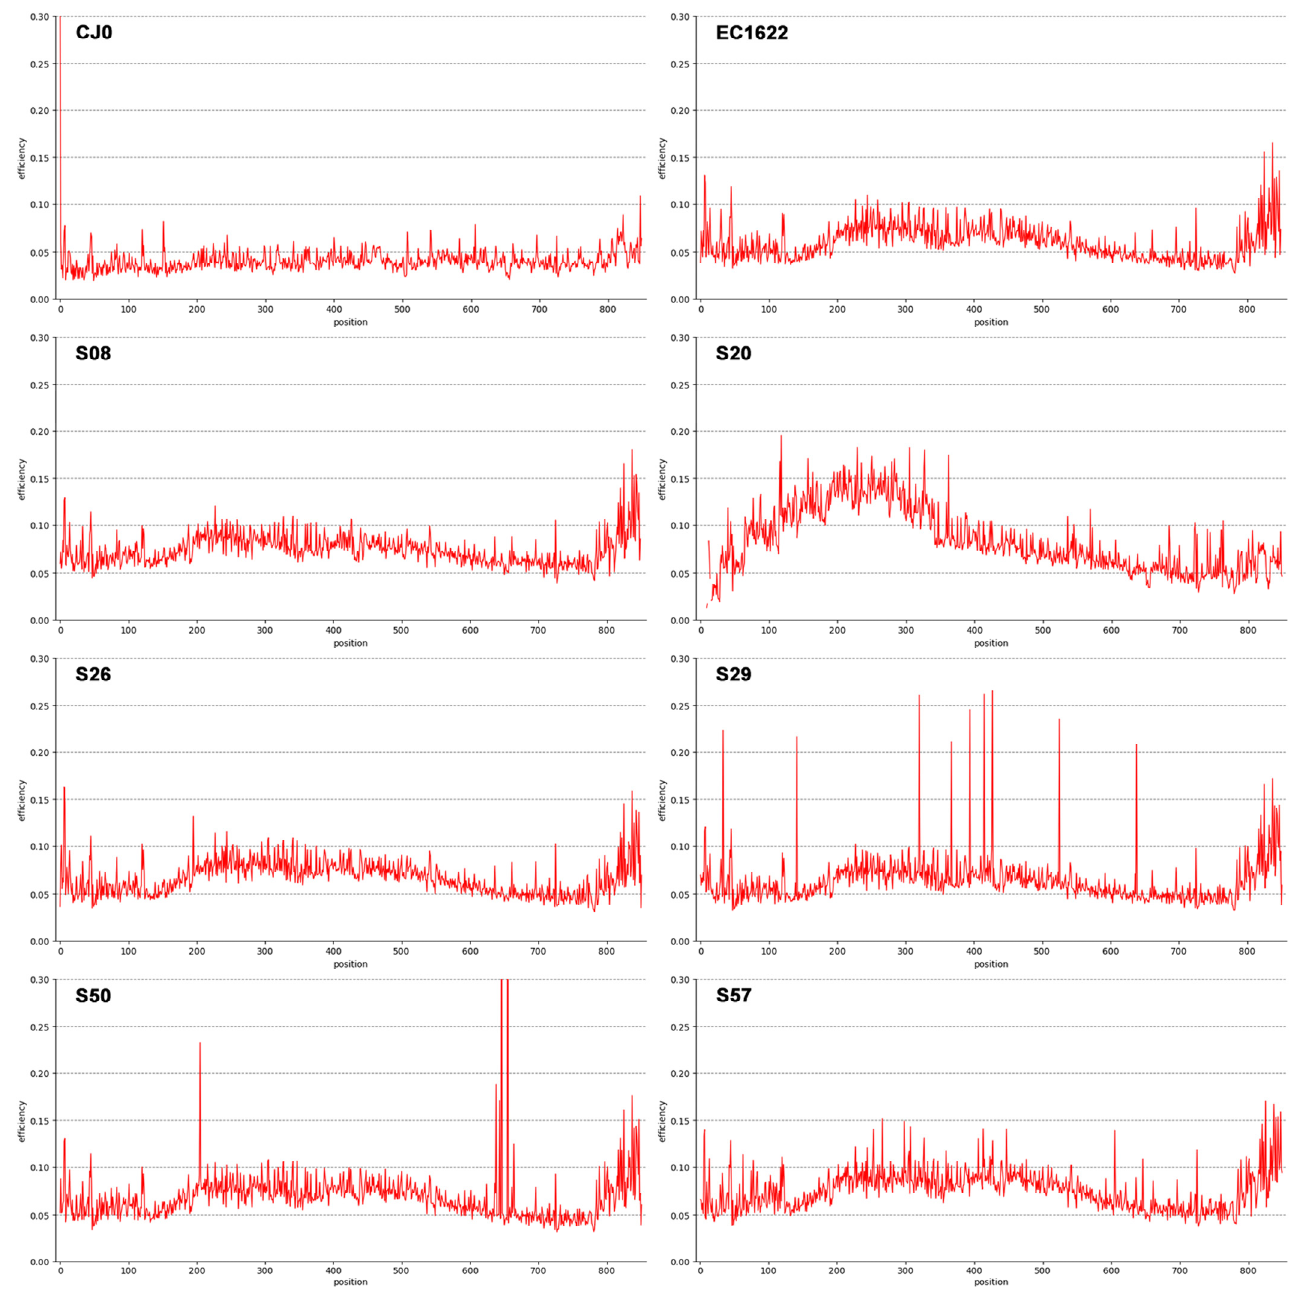
Figure 2. Line graph representation of Shannon Entropy Efficiency values in the genome segment from nt. 2390 to nt. 3242. A selection of representative samples is shown (see also Figure 3 for the complete set). CJ0 is the reference, control plasmid DNA. EC1622 is a reference B19V laboratory strain stock sample. S08, S20, S26, S29, S50 and S57 are clinical isolates. Low efficiency values and low dispersion are typical for control CJ0, virus stock EC1622 and also evident in samples S08 and S26. Higher efficiency and dispersed values can be observed for samples S20, S29, S50 and S57. In particular, sample S20 is a genotype 2 isolate showing higher variability in the first 400 nts; samples S29 and S50 show relatively low efficiency values, but distinct position-specific peaks that can be interpreted as polymorphisms; sample S57 shows a relatively higher efficiency value along with higher, more distributed dispersion.